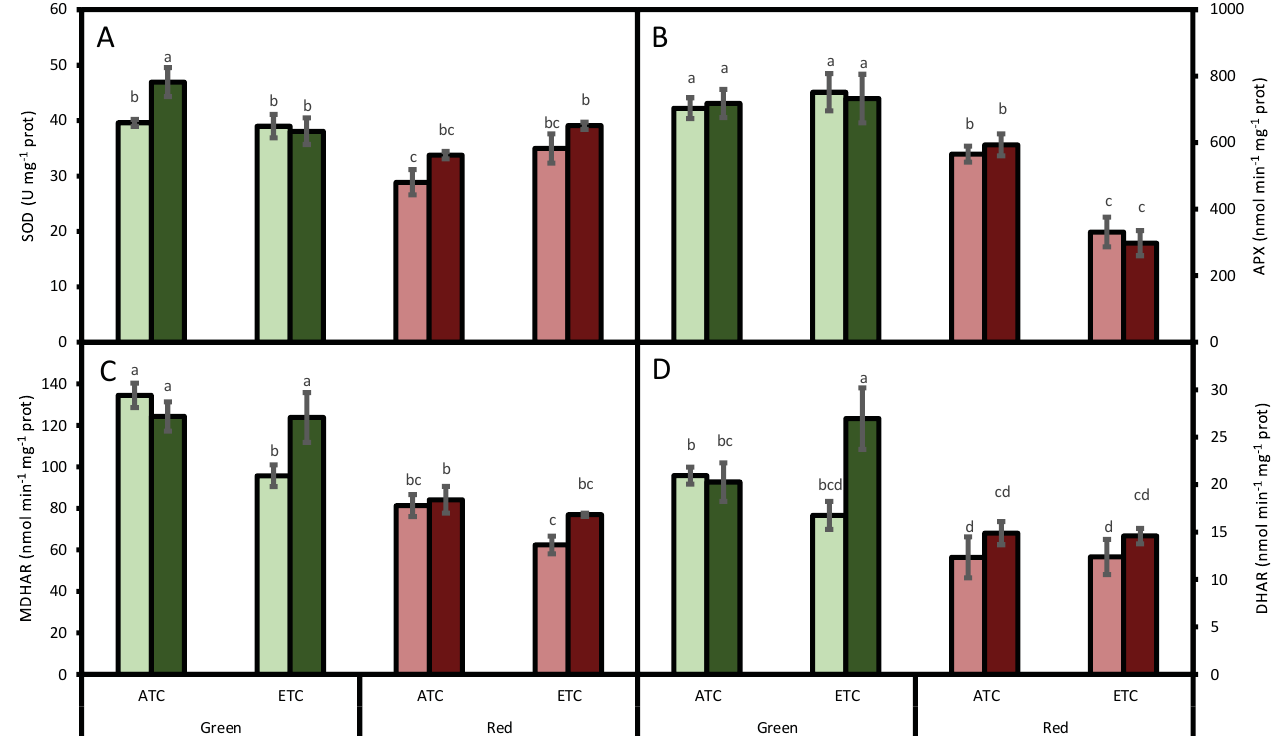
Figure 2. Effect of A. alternata inoculum and environmental conditions on the superoxide dismutase (SOD, ( A )), ascorbate peroxidase (APX, ( B )), monodehydroascorbate reductase (MDHAR, ( C )), and dehydroascorbate reductase (DHAR, ( D )) activities of two differently-colored fresh lettuces. Light green bars represent green fresh lettuces grown without inoculum (Aa − ), dark green bars represent green fresh lettuces grown with inoculum (Aa+), light red bars represent red fresh lettuces grown without inoculum (Aa − ), and dark red bars represent red fresh lettuces grown with inoculum (Aa+). (ATC) refers to lettuces grown under the present climatic scenario and (ETC) to those grown under a climate change scenario. Each value represents mean ± standard error (n = 4). Significant differences ( p < 0.05) are indicated by different letters.